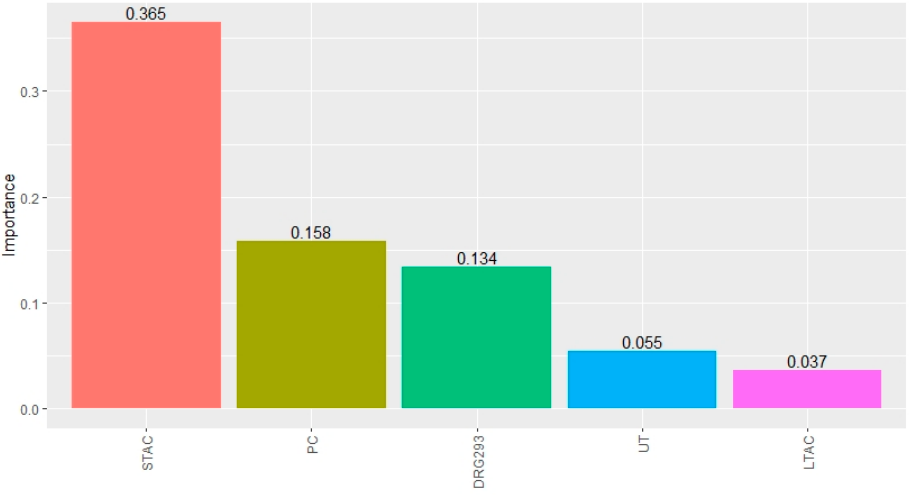
Figure 9. Variable importance measures from the extra trees regression model. STAC = Short-Term Acute Care, PC = principal component for workload, UT = the state of Utah, and LTAC = Long-Term Acute Care.